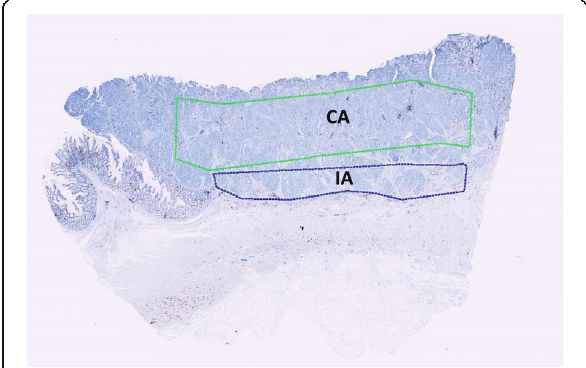
Fig. 1 Region of interest. For each tissue section the region of interest (ROI) was manually marked. Green line demarcates central tumor area (CA) and blue line the invasive area (IA), including the invasive front of the